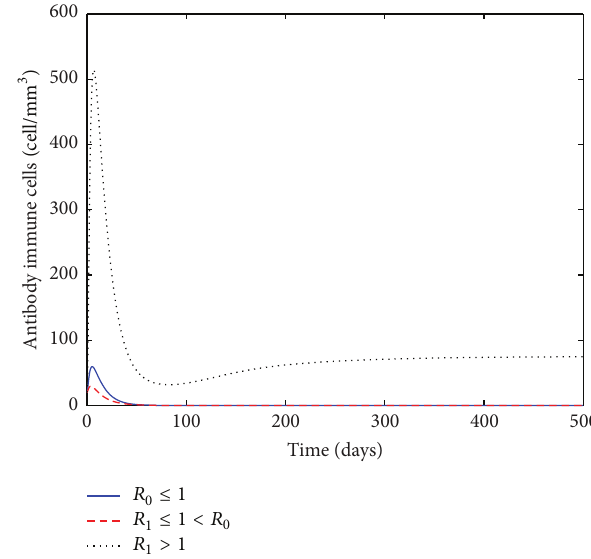
Figure 9: The evolution of free viruses for model (33)–(37). of 𝑅 1 , we can see that 𝑅 1 can be increased by increasing 𝑔 or decreasing 𝜇 and 𝛽 .